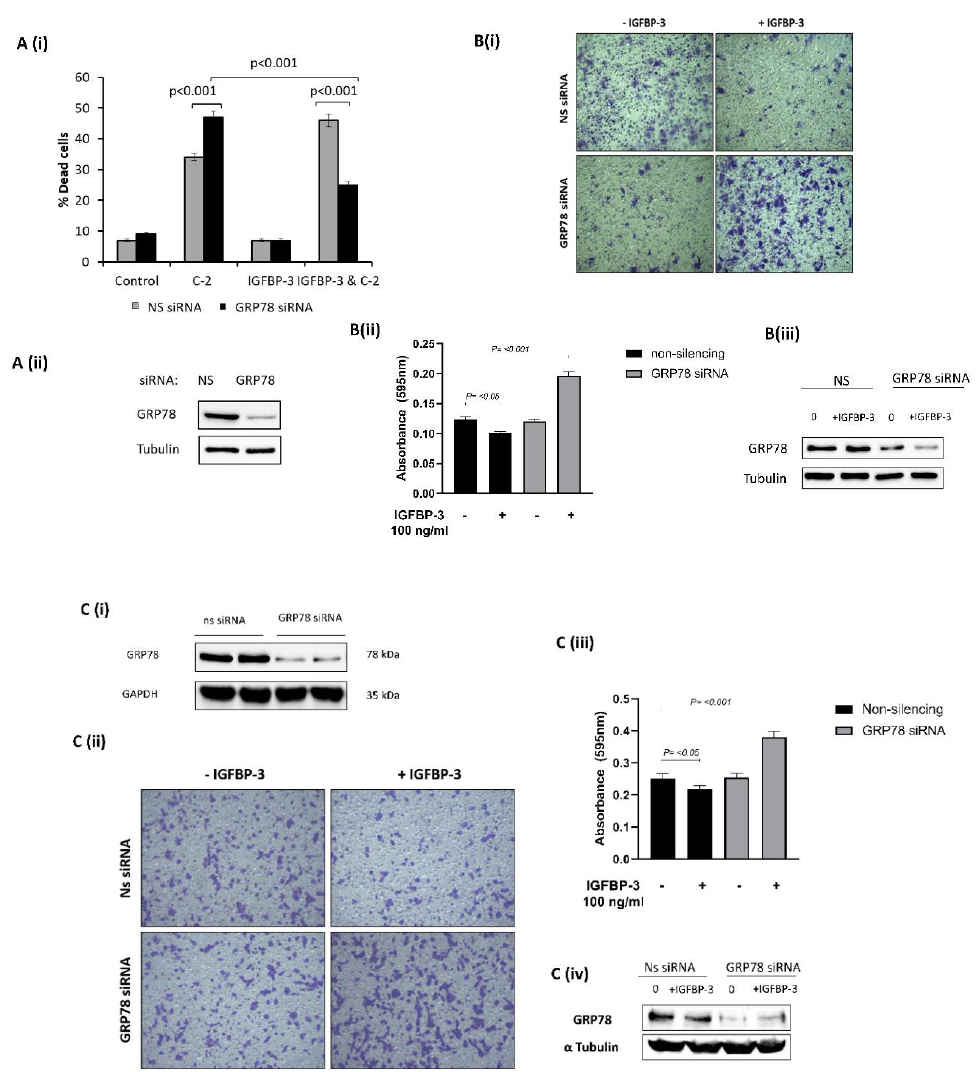
Figure 2. Loss of GRP78 alters the actions of IGFBP-3 on breast cancer cells. ( A,i ) The percentage